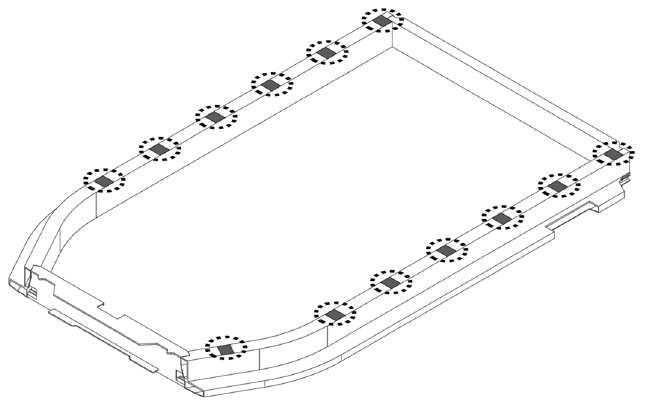
Figure 19. Temperature distribution history of the full-frame structure.